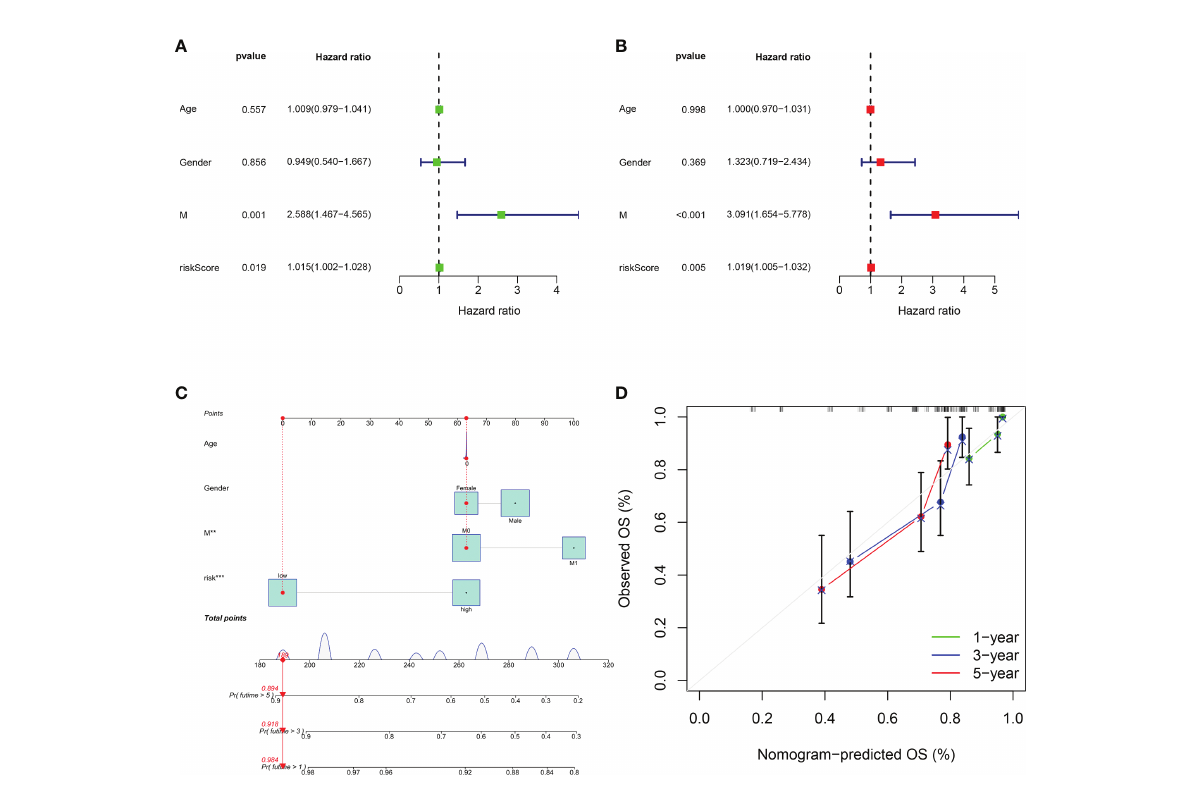
FIGURE 6 Assessment of the independent prognostic value and construction of the nomogram based on risk score and clinical factors. (A) Forest plot of univariate cox regression analysis of various clinical feature and risk score in osteosarcoma. (B) Forest plot of multivariate cox regression analysis of various clinical feature and risk score in osteosarcoma. (C) The nomogram to predict the 1-, 3- and 5-year survival risk of osteosarcoma patients. (D) Calibration curve for the 1-, 3-, and 5-year predicted survival nomogram. **P < 0.01, ***P <